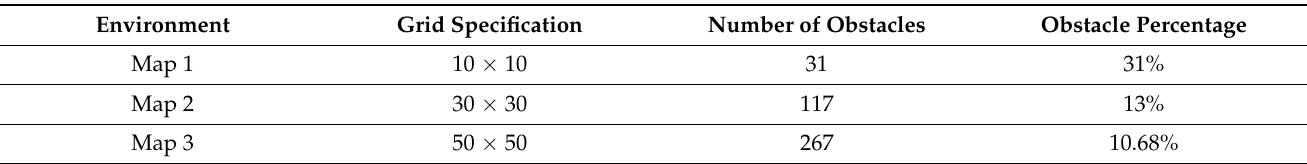
Table 8. Normal experimental environment parameters.